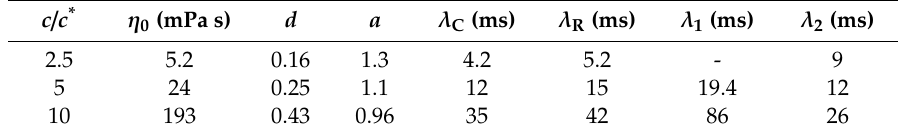
Table 1. The fitting parameters of the Carreau model and three kinds of relaxation time for comparison. c / c